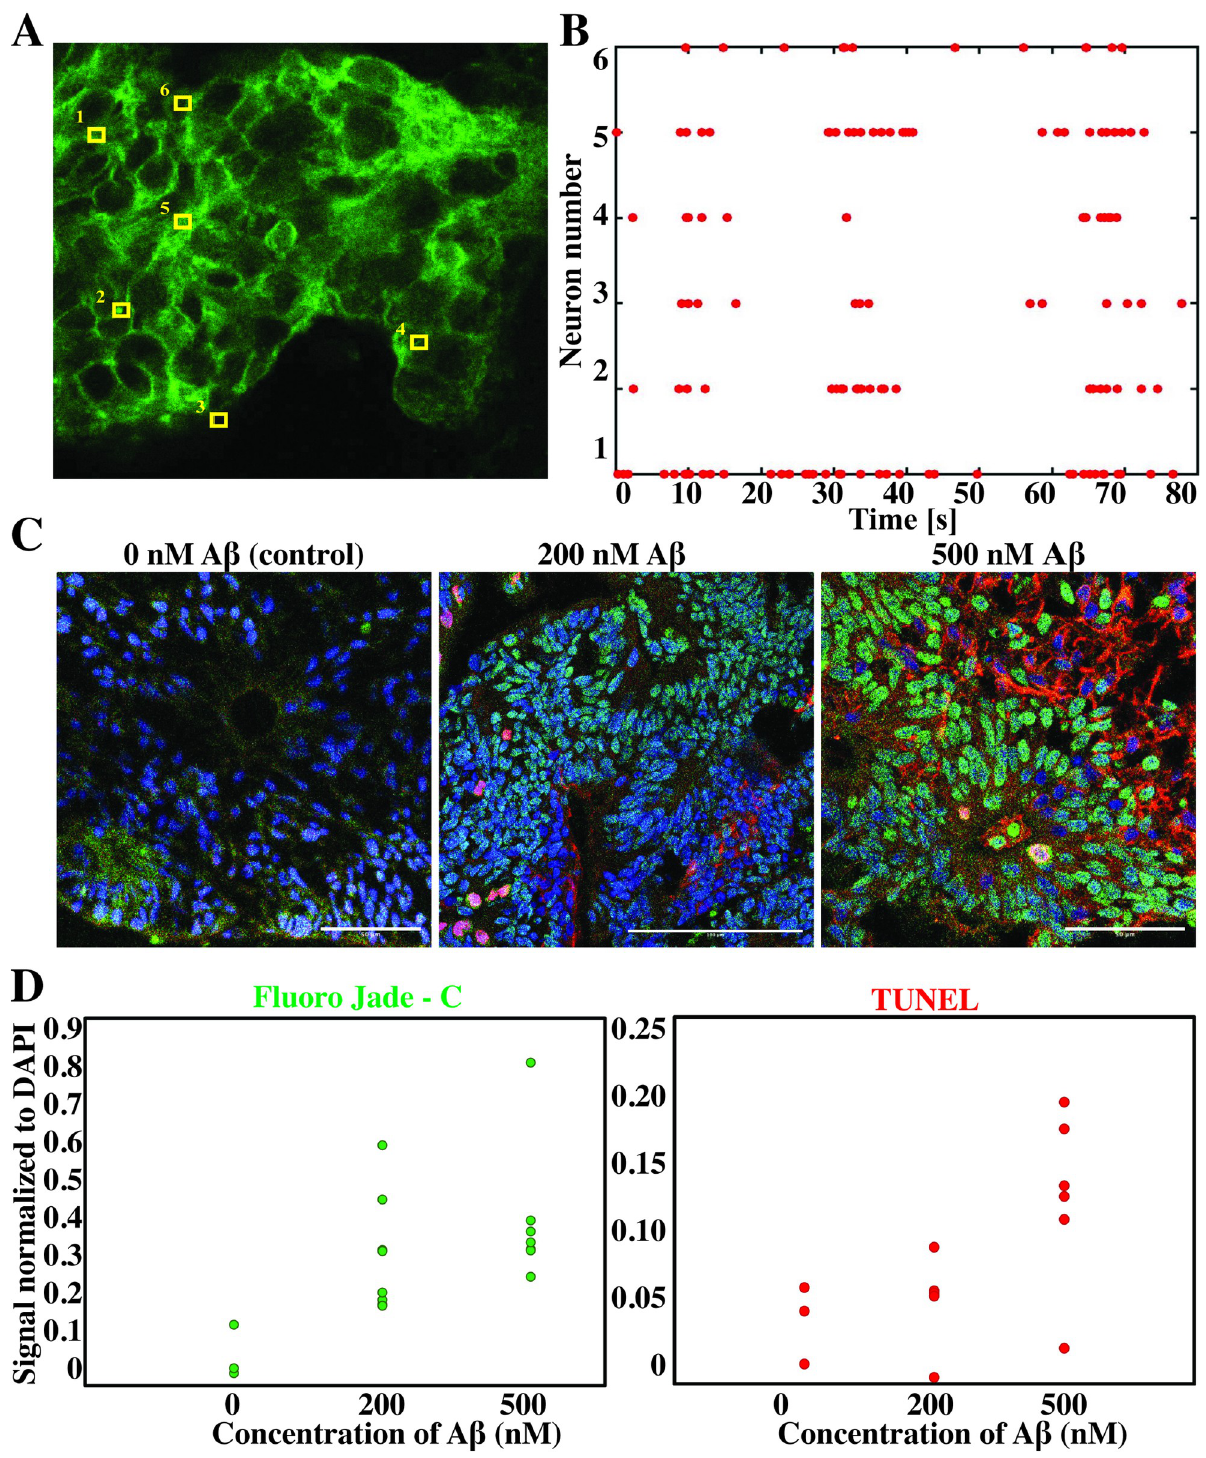
Fig 6. Functionality and possible applications of organoids derived from EBs. (A) Electrophysiological data were obtained using the voltage- sensitive FluoVolt dye. High resolution (10 ms) imaging of the measured area was used to identify individual neurons. (B) Raster plot of 6 individual neurons shown in (A) reveals frequent neuron firing and suggests synchronous activity at day 60. (C) Disease modeling was tested by exposing the organoids to 200 nM and 500 nM concentrations of soluble amyloid beta (A β ). (D) Damage was assessed using the Fluor Jade-C fluorescent marker (green) and (E) cell death with the BrdU TUNEL assay (red). Fluorescence images showed the location of the damage. Scale bar: 100 μ m. Quantification of the fluorescent image area normalized against the DAPI (blue) signal. https://doi.org/10.1371/journal.pone.0262062.g006 PLOS ONE | https://doi.org/10.1371/journal.pone.0262062 May 10,